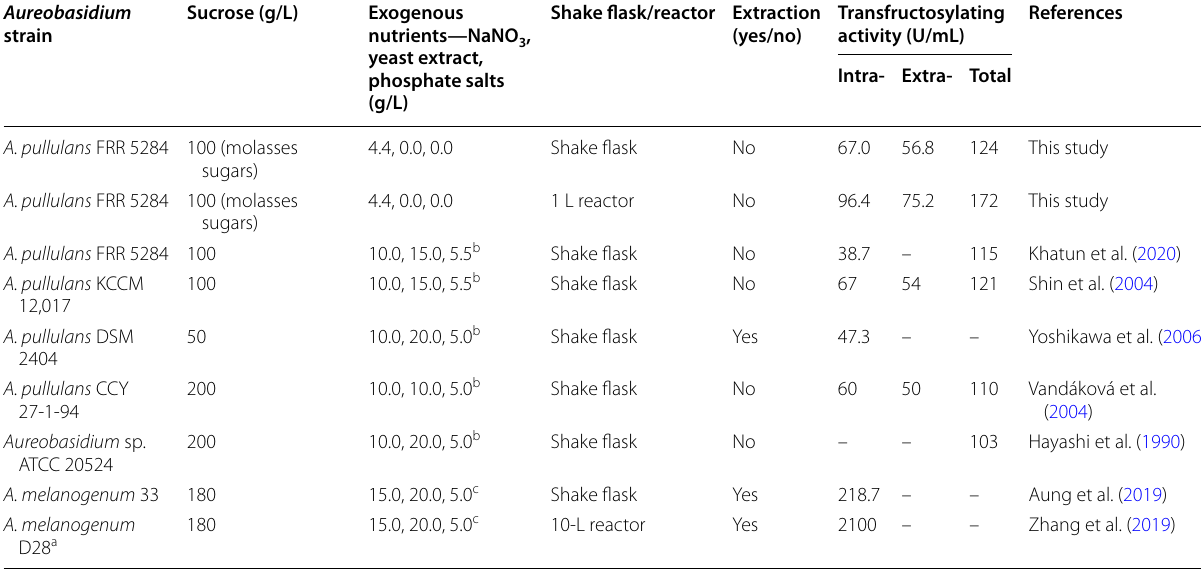
Table 3 Comparison of transfructosylating activities produced by Aureobasidium strains